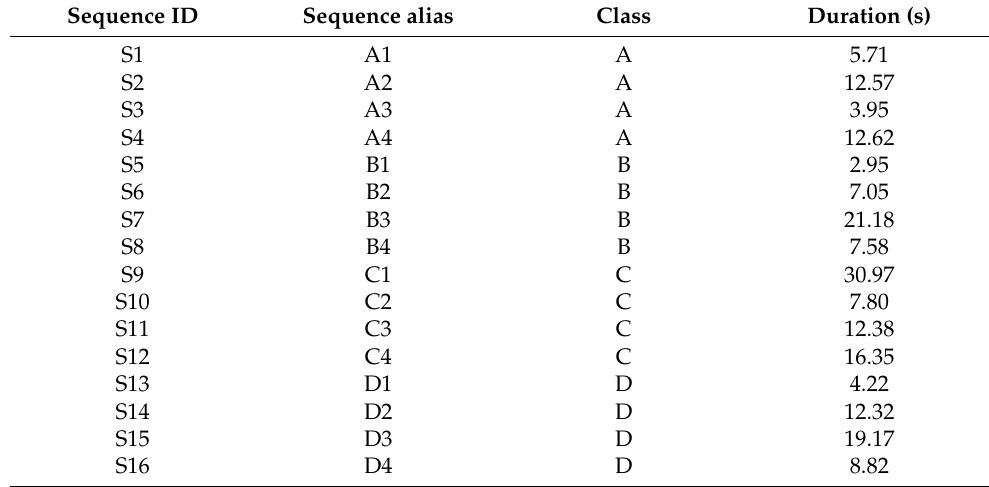
Figure 6. Motion vectors—high temporal complexity example. Table 1. Basic sequence